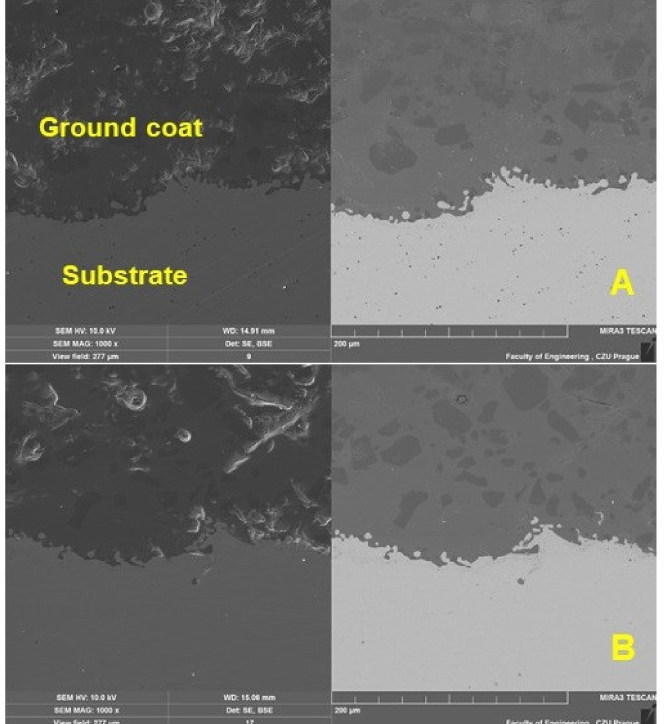
Figure 6. SEM analysis of the cross-section of the test specimen before wear—the interface metal material (substrate) and the base enamel surface fused to the metal surface (SE Oxford detector—left, BSE Oxford detector—right): ( A ): original enamel (MAG 1.0k × ), ( B ): renovated enamel applied by local heating (MAG 1.0k ×